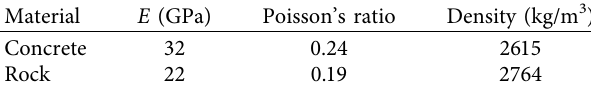
Figure 1: Boundaries of the Ermenek arch dam [34]. Table 1: Material properties of Ermenek arch dam